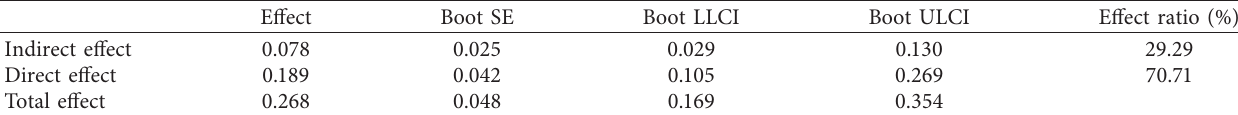
Table 5: Total effect, direct effect, and indirect effect.